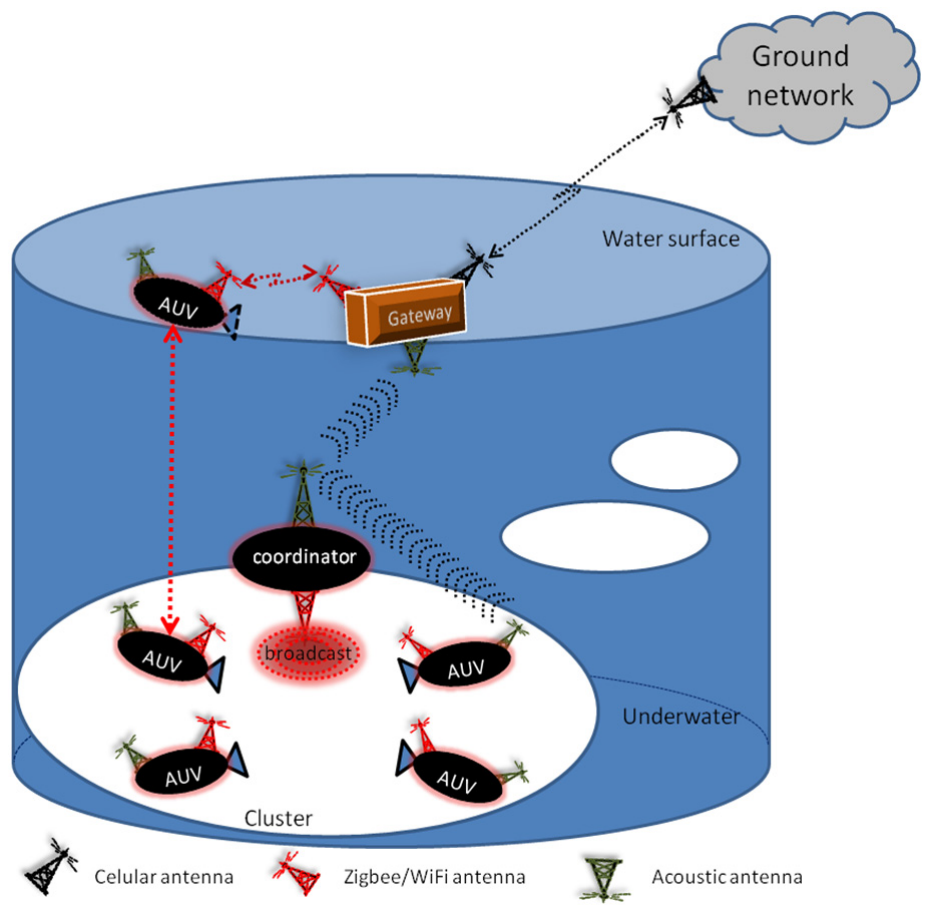
Figure 2. Network topology and